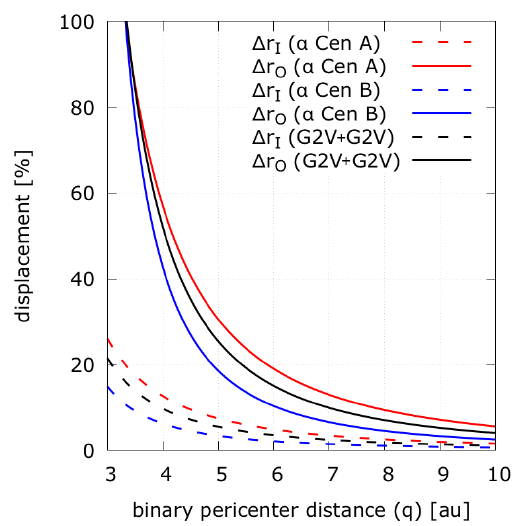
Figure 4. A visualization of Equation (19) showing the maximum displacement of the inner ( I , dashed) and outer ( O , continous) border of the isophote-based habitable zone as a function of the binary orbit pericenter distance q . The displacement is given in relative to the original single star habitable zone borders. A ∆ a = 100% means that the new border is twice as far from its host star than the single star habitable zone pendant. We consider α Centauri-like systems and a binary consisting of two sun-like (G2V)